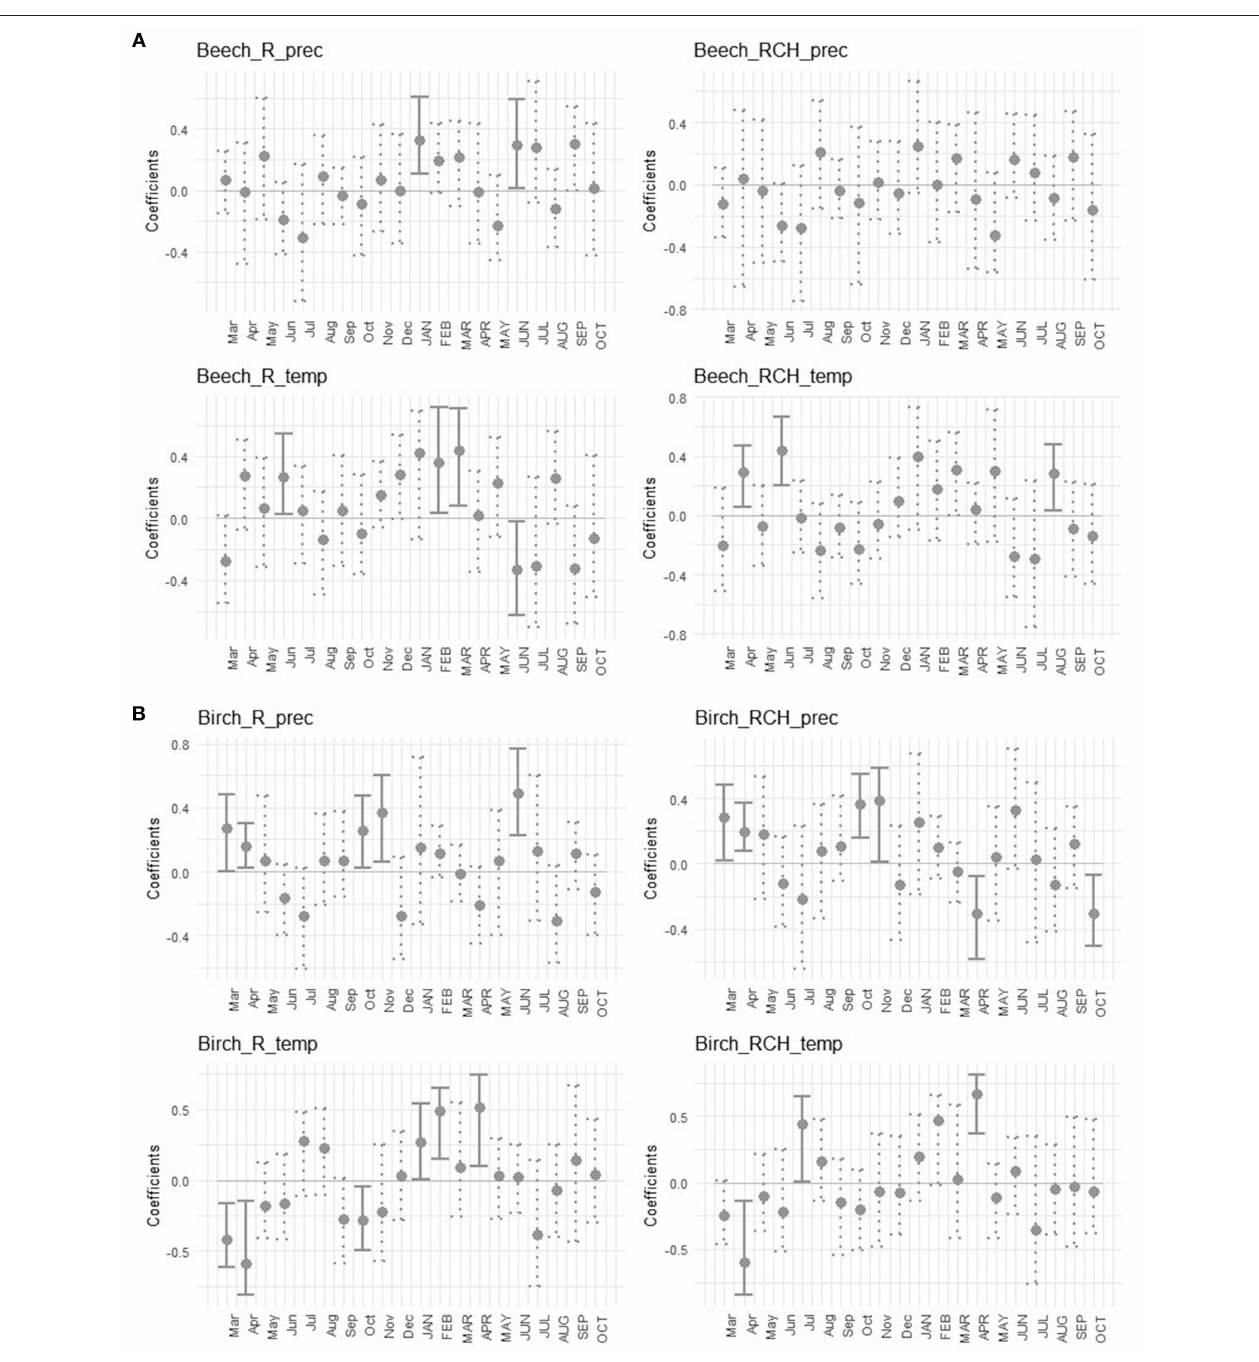
FIGURE 6 | Bootstrapped correlation values of mean standardized chronologies for ( A , above) European beech and ( B , below) silver birch, growth in reference (R) and relic charcoal hearths (RCH) plots, and total monthly precipitation (prec) and mean temperature (temp). Correlations were separately calculated for each month for the period from March of the previous year (lowercase letters) to October of the current year (uppercase letters). The bars indicate a significant coefficient at p < 0.05, lines represent 95% confidence interval. Solid lines underline significant correlation values and dotted lines identify not significant correlation values.